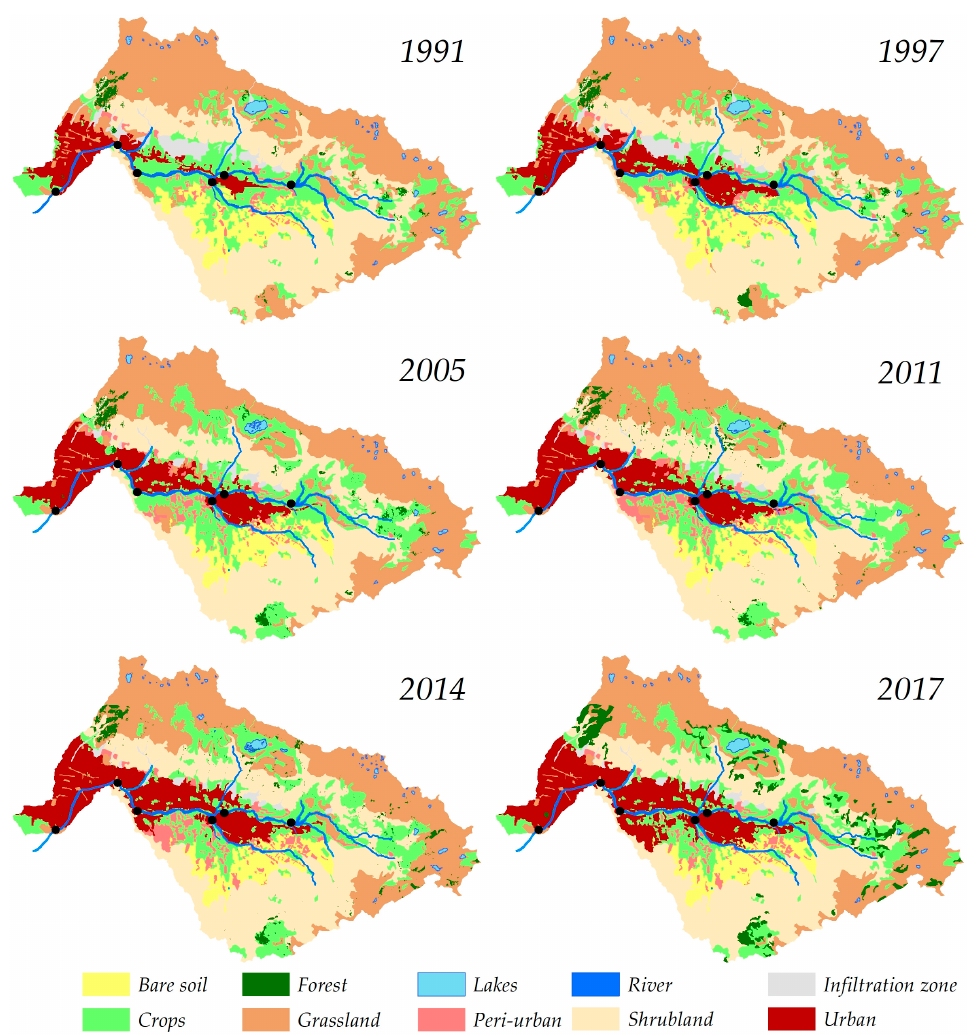
Figure 5. Land use in the Rocha River catchment during the years 1991, 1997, 2005, 2011, 2014, and 2017, divided into 10 classes. Black dots are (left to right) stations 1, 2, 3, 4, 5, and